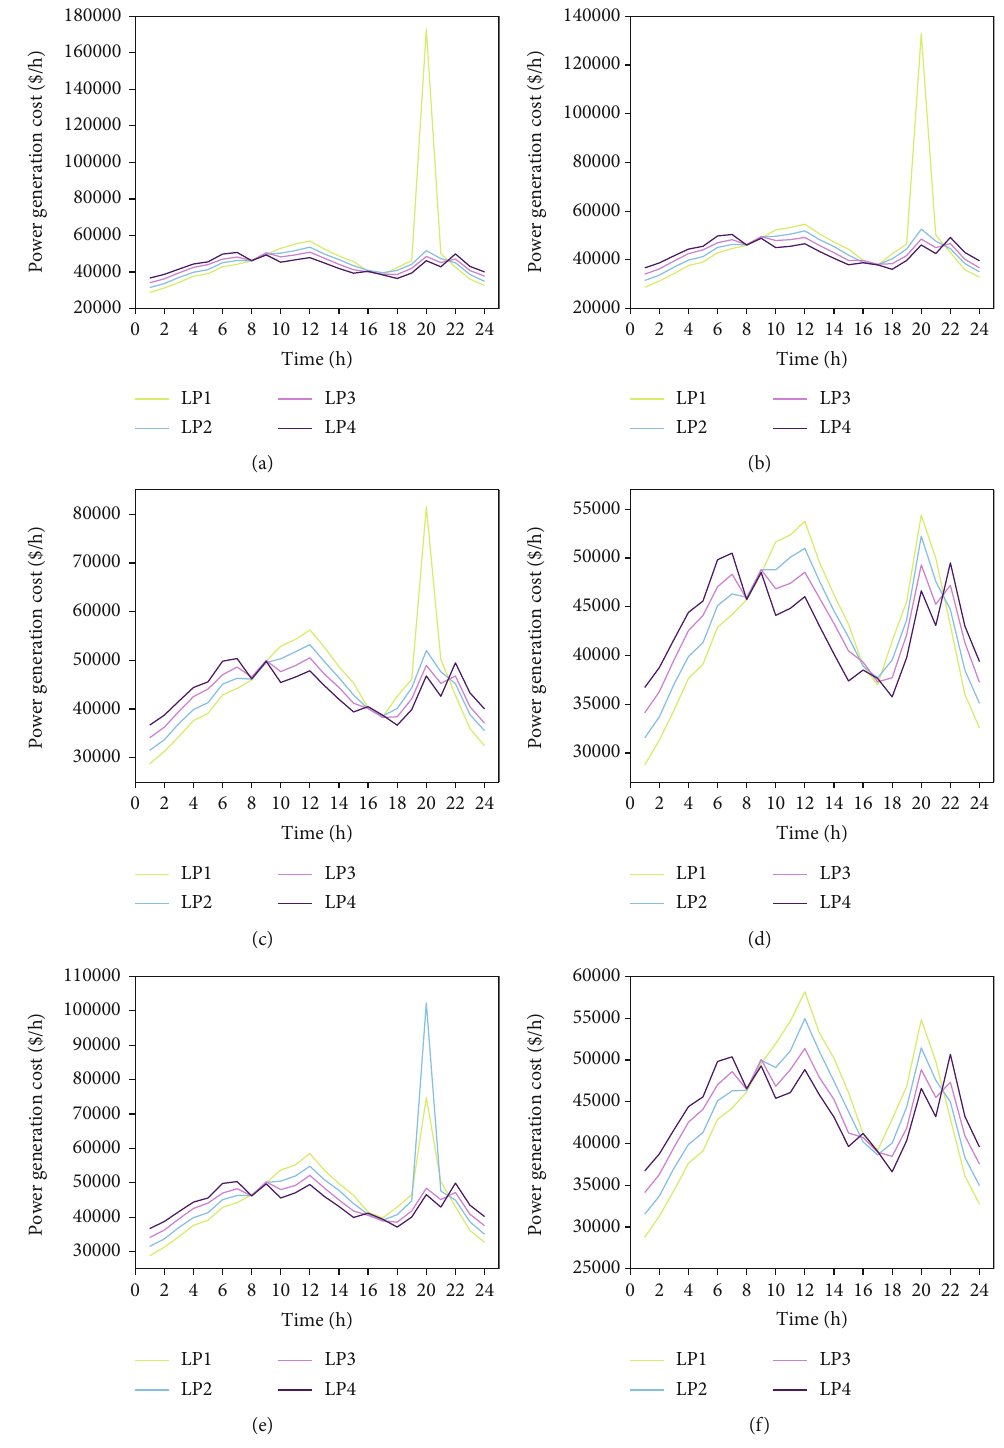
Figure 5: Hourly power generation costs for the 24h DEDs of the load pro fi les (LPs) under (a) 10% average, (b) 30% average, (c) 10% abundant, (d) 30% abundant, (e) 10% scarce, and (f) 30% scarce solar penetration levels and resource